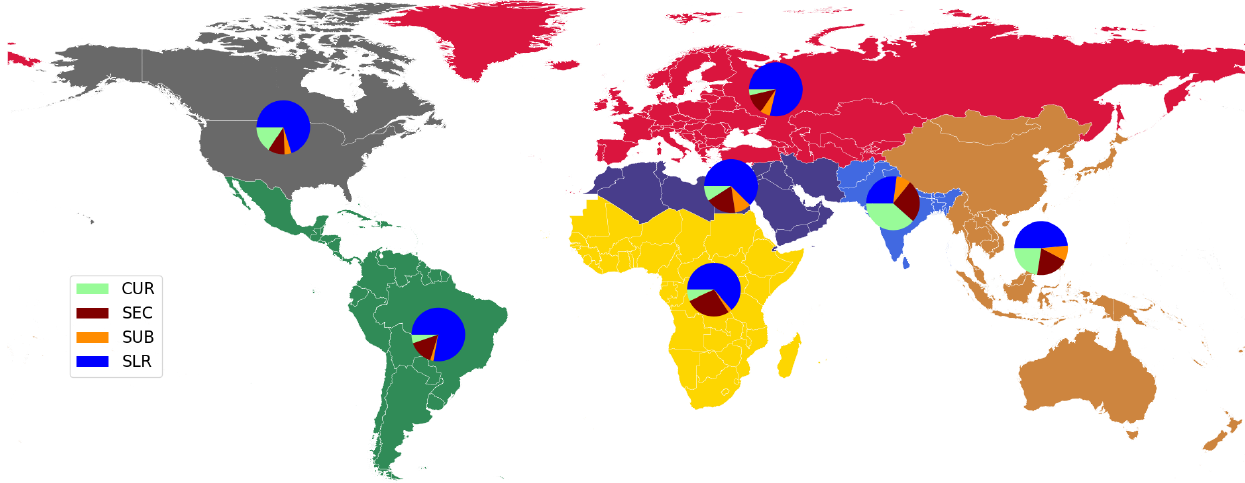
Figure 10. Attribution of costs of adaptation for World Bank regions under the optimize adaptation objective and RCP4.5–SSP2 for optimiz- ing to current conditions (CUR), socioeconomic change (SEC), subsidence (SUB), and sea-level rise